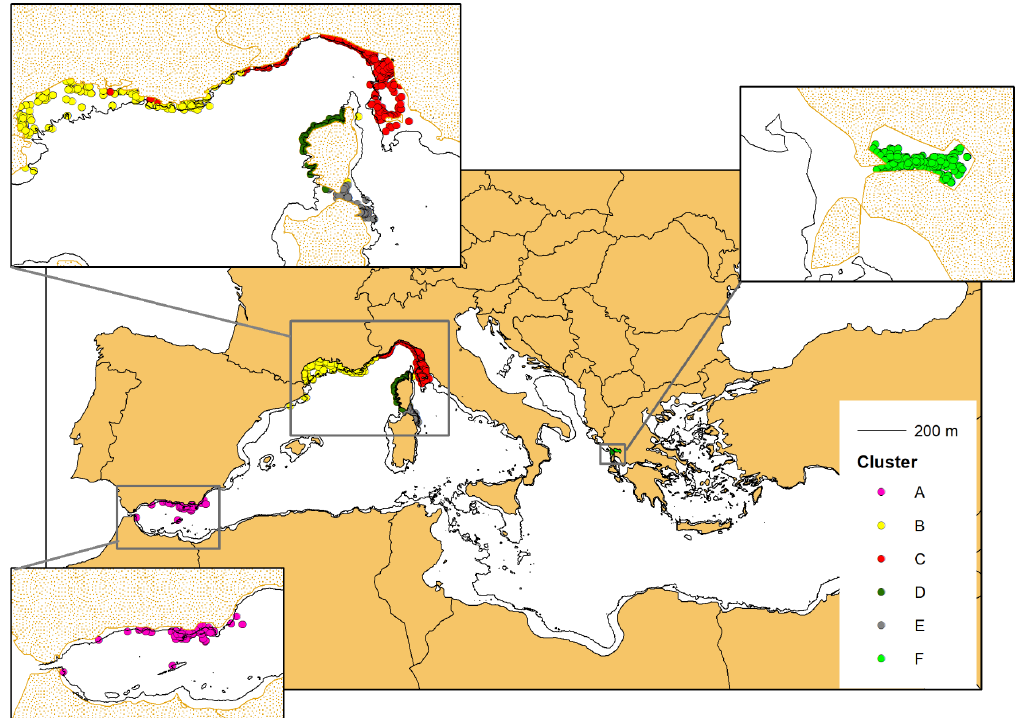
Figure 6. The sighting positions of the photo-identified bottlenose dolphins with at least four captures (703 individuals). The colours correspond to the belonging cluster (see Figure 5).